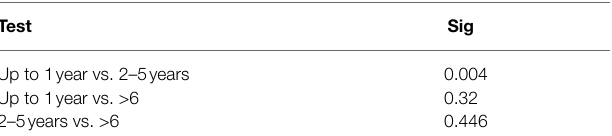
TABLE 8 | Post-hoc test.